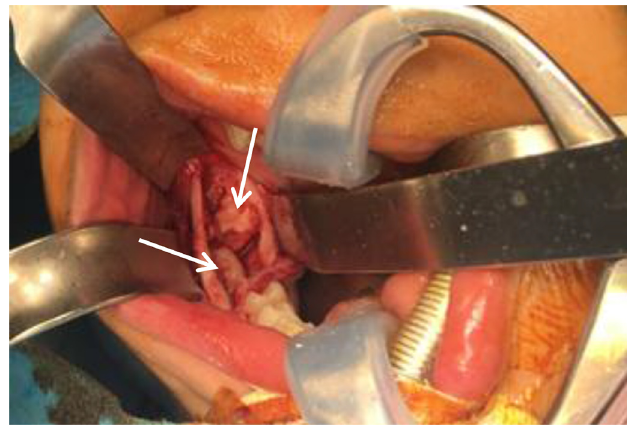
Fig. 4. Intra oral intraoperative photograph showing 47 48 position